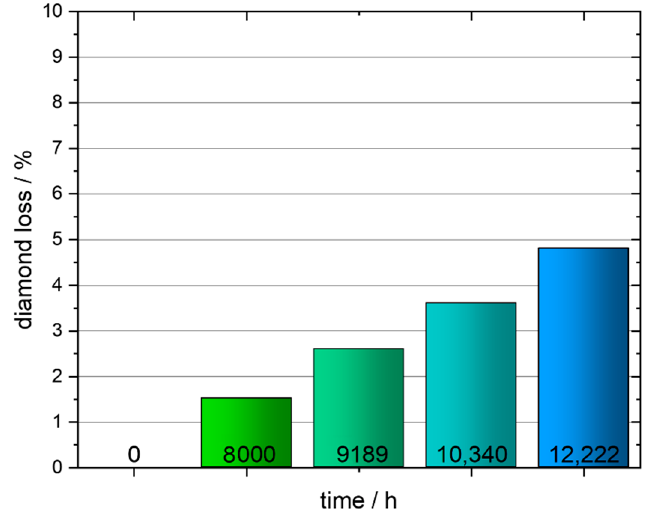
Figure 4. Evolution of the diamond loss during phenolic wastewater treatment over 12,222 h.